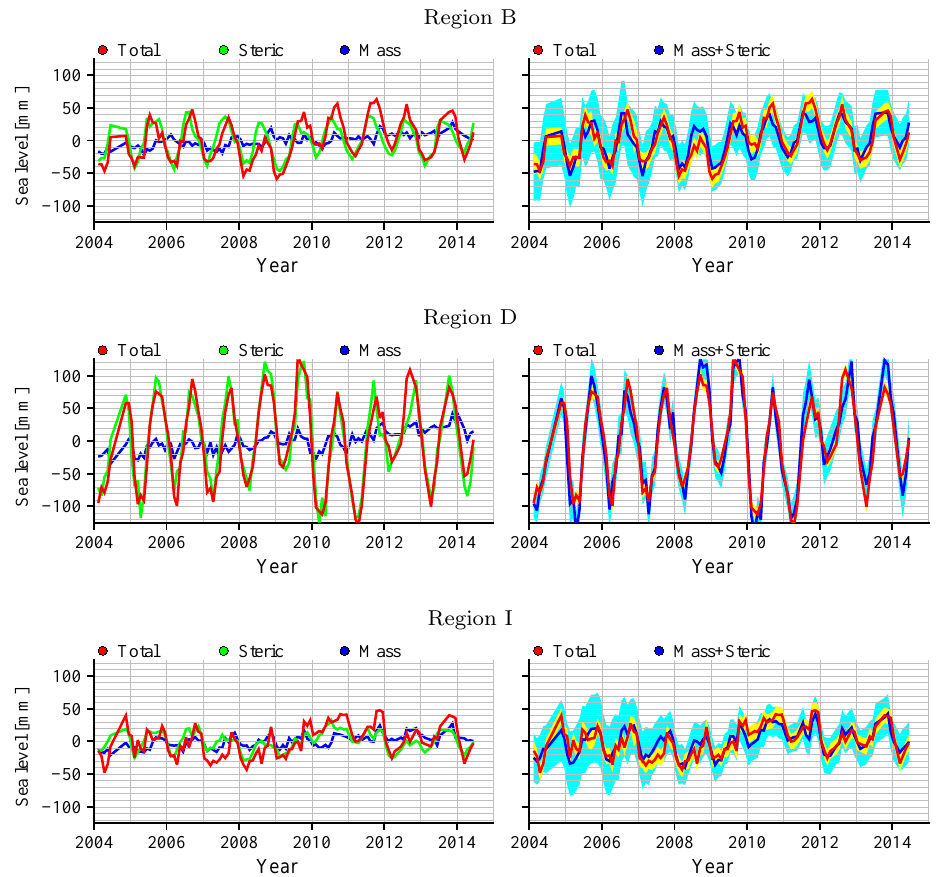
Figure 9. Time series of sea level components for regions B, D and I. Left: total sea level from altimetry in red, steric sea level in green and the ITSG90-W mass in blue. Right: total sea level from altimetry in red and the sum of steric sea level and mass in blue. In yellow and light blue: their 95% confidence interval. Table 4. Trends of total sea level (mmyr − 1 ) and their standard deviations from altimetry (Jason) and the sum of steric and mass from Argo (A.) and GRACE (CSR, ITSG) for different filter solutions. NA is the trend for the complete North Atlantic Ocean between 0 and 65 ◦ N. A 0.4mmyr − 1 drift error is taken into account for altimetry based on the comparisons with tide gauges (Mitchum, 1998, 2000). Jason CSR96 + A. CSR96 + A. CSR60 + A. ITSG90 + A. GIA GIA DDK5 Wiener Wiener